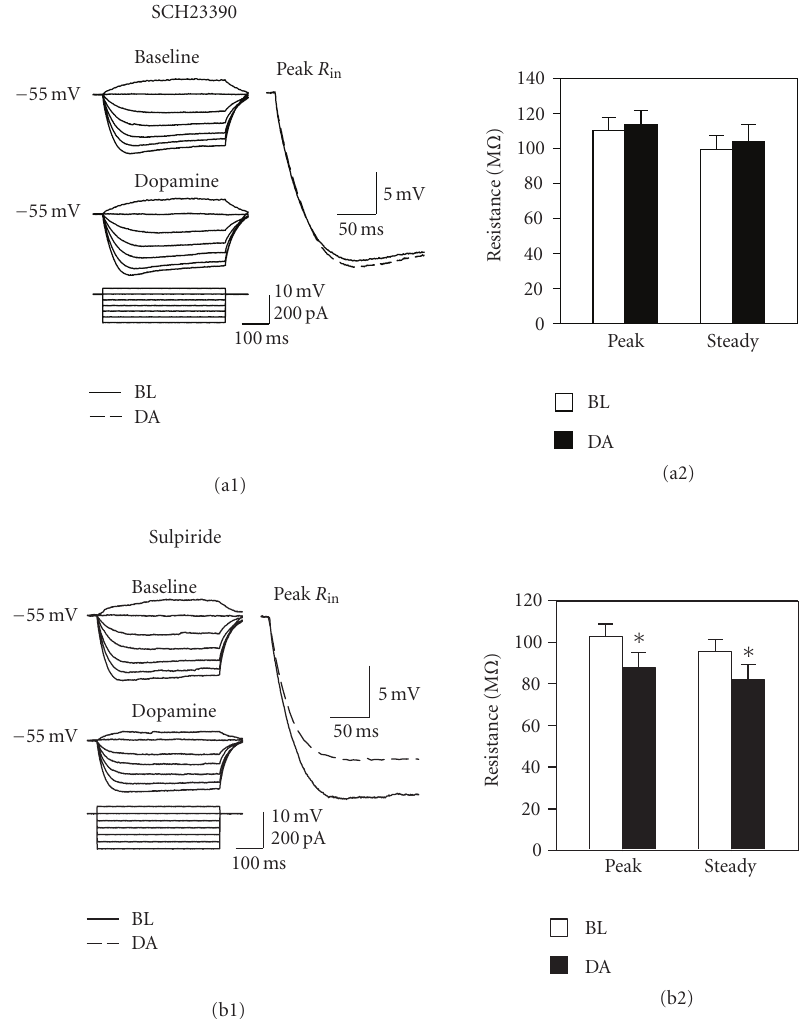
Figure 8: Blockade of D 1 , but not D 2 , receptors prevents the dopamine-induced reduction in input resistance. (a) Bath-application of the D 1 receptor antagonist SCH23390 (50 μ M) prevented the reduction in input resistance induced by 50 μ M dopamine. Traces at left show voltage responses to a series of current steps during baseline recordings in SCH23390 and during subsequent dopamine application. Traces at right compare the initial voltage responses to − 200 pA steps before and after dopamine application. Note that input resistance is unchanged when D 1 receptors are blocked. (b) The D 2 receptor blocker sulpiride (50 μ M) does not prevent changes in input resistance induced by dopamine ( ∗ , P < .